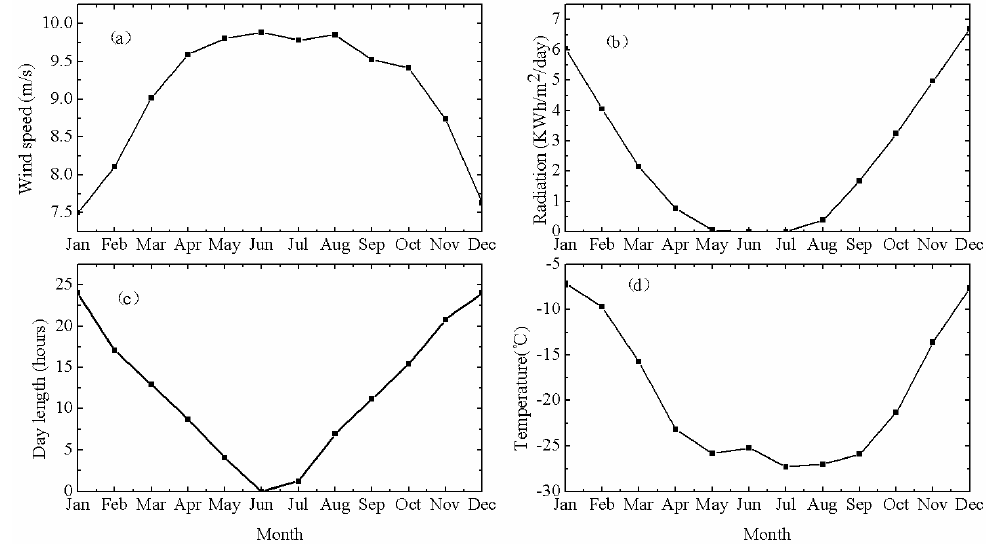
Figure 3. Monthly meteorological data of Zhongshan Station, Antarctica. ( a – d ) Monthly wind speed, solar radiation, day length, and air temperature, respectively.